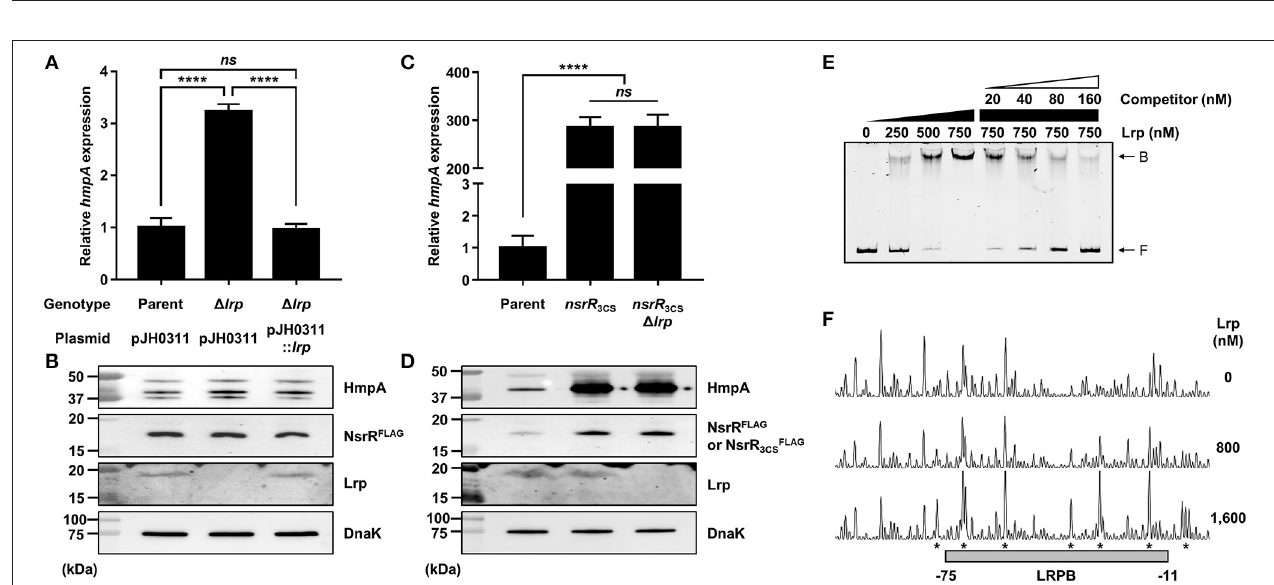
FIGURE 6 | The effect of the lrp mutation on hmpA transcription and the specific binding of Lrp to the nsrR - hmpA regulatory region. (A–D) Total RNA and proteins were isolated from the parent and mutant strains grown aerobically to an A 600 of 0.5. (A,C) The hmpA transcript levels were determined by qRT-PCR, and the hmpA transcript levels in the parent strain were set to 1. Error bars represent the SD. Statistical significance was determined by the Student’s t -test ( **** p < 0.00005; ns , not significant). (B,D) The cellular HmpA, NsrR FLAG or NsrR FLAG 3CS , Lrp, and DnaK (internal control) protein levels were determined by Western blot analysis. Molecular size markers (Bio-Rad) are shown in kDa. Parent, parent strain; 1 lrp , lrp -deletion mutant; pJH0311, broad-host-range vector; pJH0311:: lrp , pJH0311 carrying the lrp gene (pZW1818); nsrR 3CS , strain expressing apo-locked NsrR FLAG ; nsrR 3CS 1 lrp , lrp -deletion mutant expressing apo-locked NsrR FLAG . (E) A 393-bp DNA fragment of the nsrR - hmpA regulatory region (10nM) was labeled with 6-FAM, and then incubated with increasing amounts of Lrp as indicated. For the competition analysis, various amounts of the unlabeled DNA fragment were added as a self-competitor. B, bound DNA; F, free DNA. (F) The same DNA probe (40nM) was incubated with increasing amounts of Lrp as indicated, and then digested with DNase I. The region protected by Lrp is indicated by a gray box (LRPB). The nucleotides showing enhanced cleavage are indicated by asterisks. Nucleotide numbers shown are relative to the TSS of hmpA .